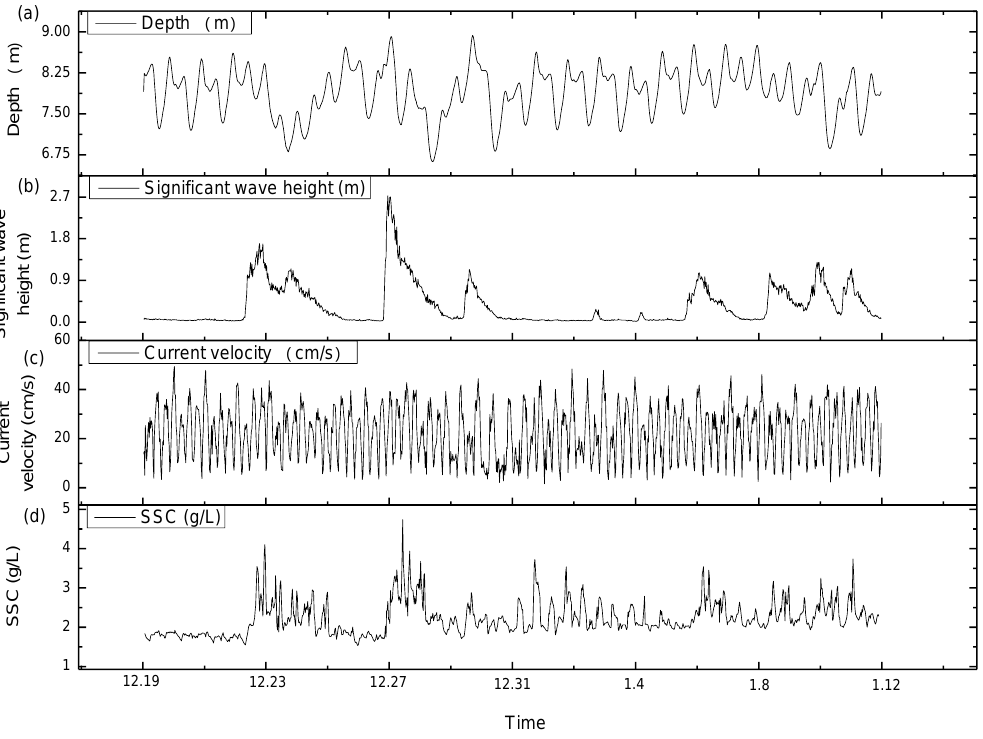
Figure 5. ( a ) Water depth, ( b ) significant wave height, ( c ) current velocity, and ( d ) average SSC from 19 December 2016 to 11 January 2017.